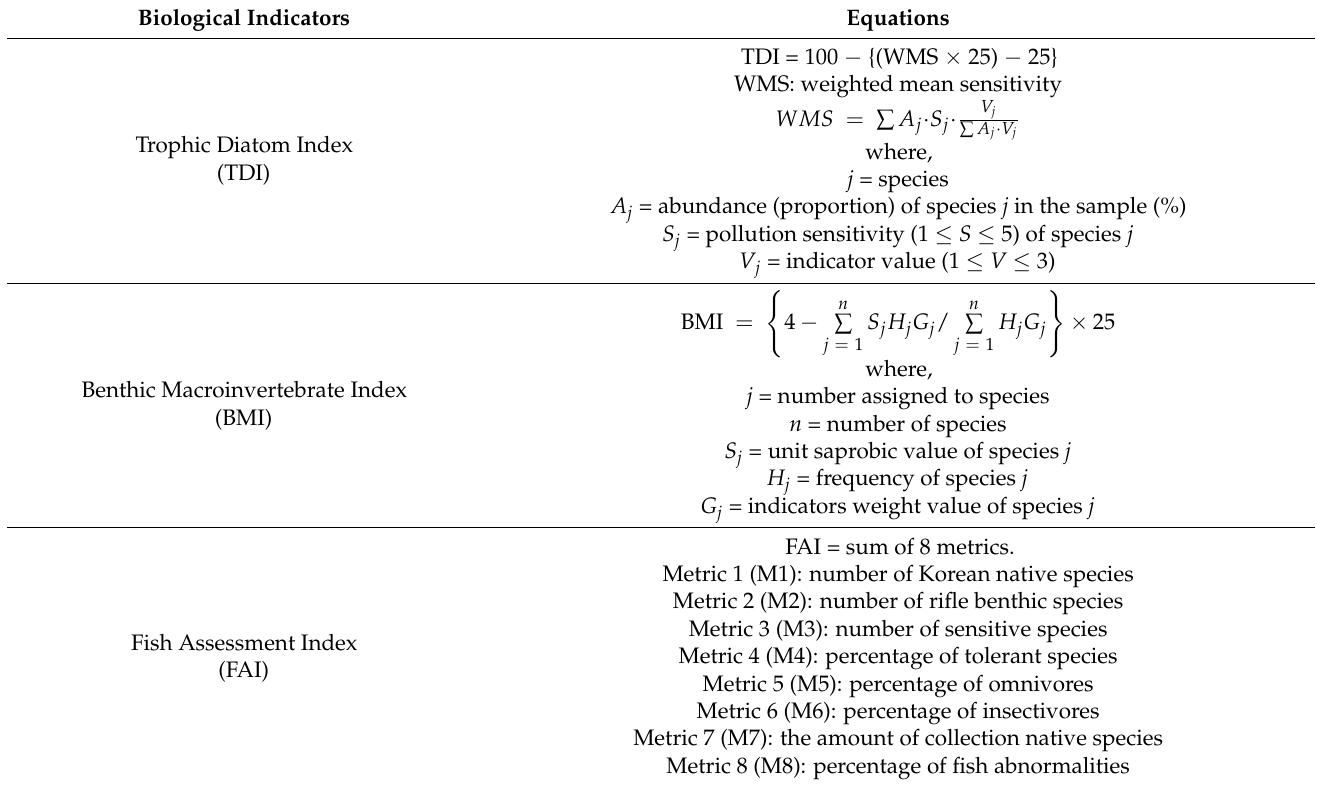
Table 1. Equations for computing biological indicators, from the Korean Ministry of Environment (MOE) [38]. Biological